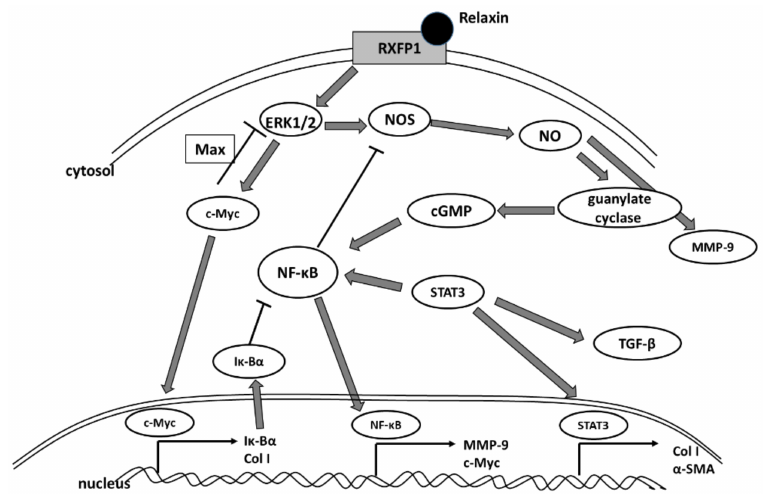
Figure 6. A schematic illustration of the proposed relaxin signaling at the cellular level. NF- κ B mediates induced collagen I expression and NALP3 inflammasome,